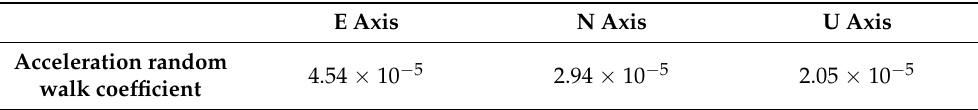
Table 2. The calibration results of the three-axis acceleration random walk coefficient (unit: m/s 2 · sqrt